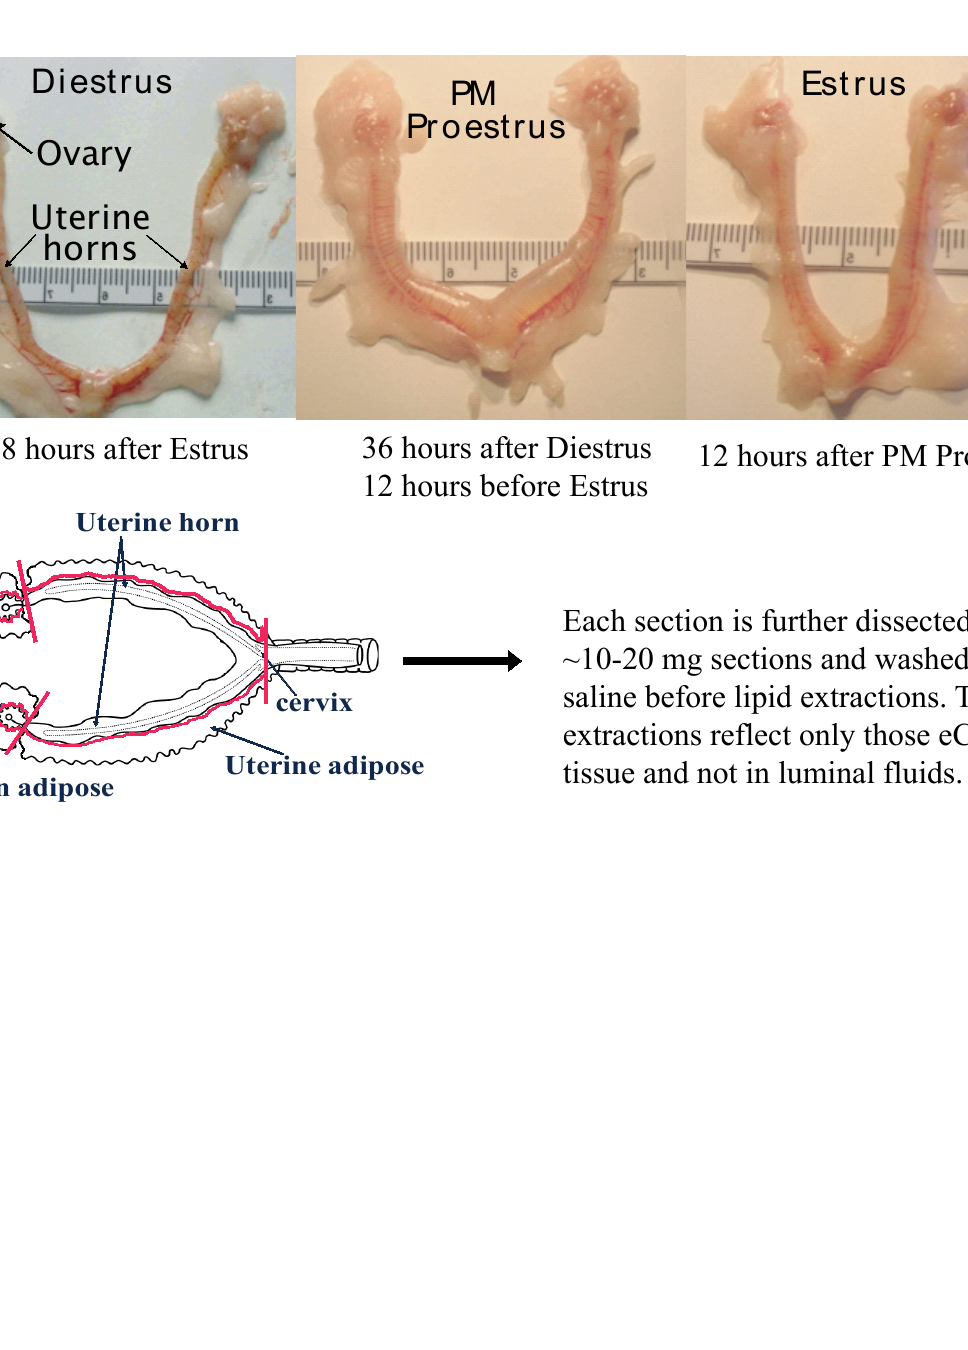
Figure 1. Female rat reproductive tract across the hormonal cycle and plan for dissection of tissue . Reproductive tract physiology changes dramatically across the hormonal (estrous) cycle of the rat. The bicornate uterine horns are inflamed on the evening of proestrus (PM proestrus) during sexual receptivity. In the absence of a copulatory signal, the uterine horns undergo a reduction in luminal fluid retention and size by the morning of Estrus. To determine the production of eCB ligands during these changes the reproductive tract was dissected into four gross tissue types: ovaries, ovarian adipose, uterine horns (referred after as uterus), and uterine adipose